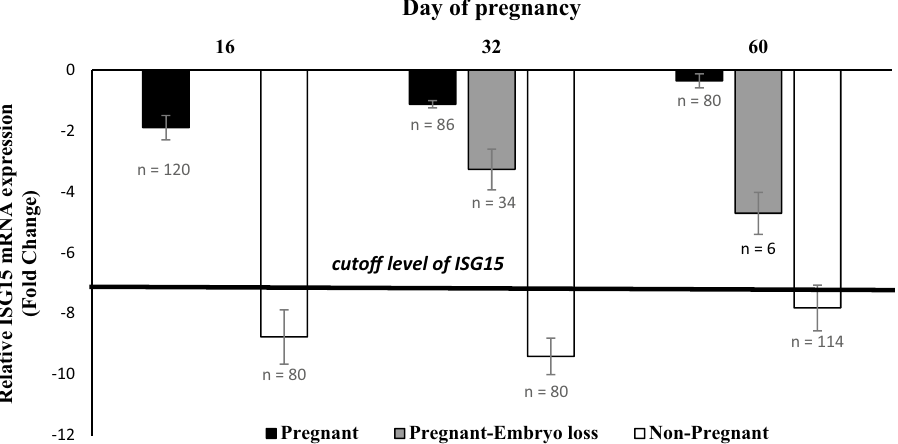
Figure 1. Relative mRNA expression of interferon stimulated gene ISG15 in peripheral blood leukocytes of samples on d 16 after AI, according to pregnancy statuses at 16, 32 and 60 days after AI. Error bars represent the 95% CI of the adjusted fold change. Black bars represent ISG15 expression at day 16 for cows diagnosed pregnant at days 16, 32 and 60 days. Shaded bars represent cows losing embryos between 16 and 32 days (n = 34) and 32–60 days (n = 6). The white bars on days 16 and 32 are ISG15 expression values for non-pregnant cows. The white bar on day 60 (non-pregnant): is an accumulative response of non-pregnant cows: 80 cows non- pregnant at day 16, 34 cows that lost embryos by day 32, and 6 cows losing embryos between days 32 and 60, which is a total of 114 non-pregnant